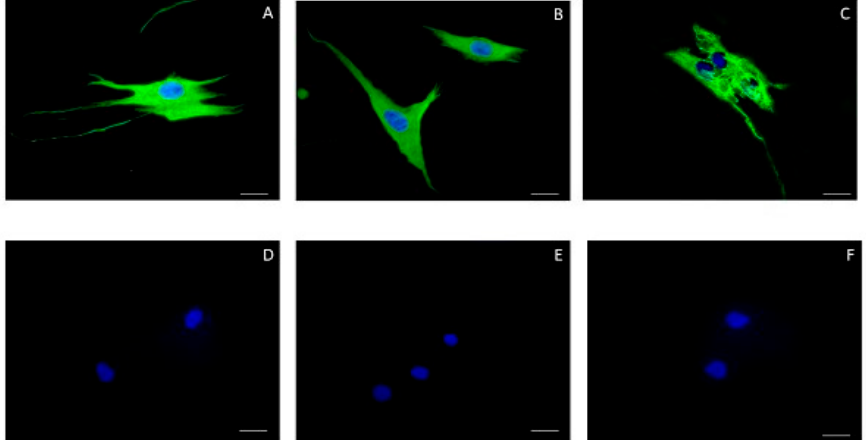
Figure 2. Indirect immunofluorescence. Fibroblasts of periodontal ligament expressed vimentin ( A ) and fibronectin ( B ), but no cytokeratin AE1/AE3 ( C ). Negative controls were shown on ( D – F ). Nuclear staining was performed with Hoechst. Scale bar = 20 μ m.